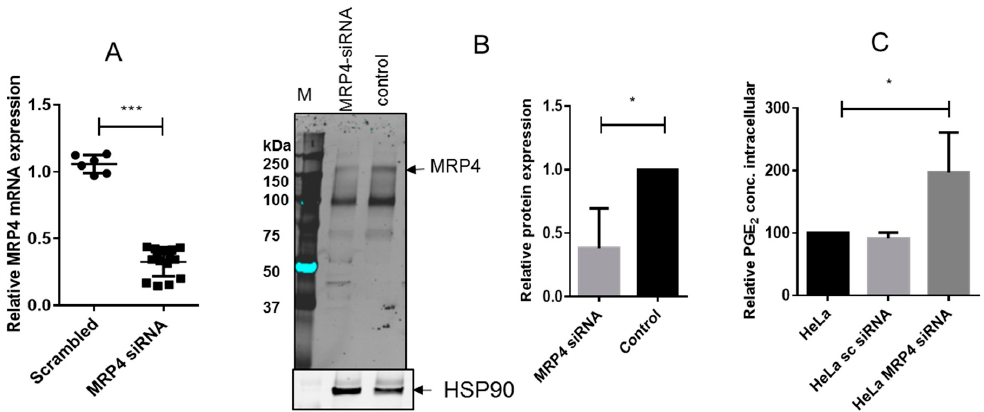
Figure 5. ( A ) MRP4 mRNA expression in HeLa cells after transfection of scrambled or MRP4 siRNA. Means ± S.E.M. of three independent experiments, determined in triplicate, are shown.